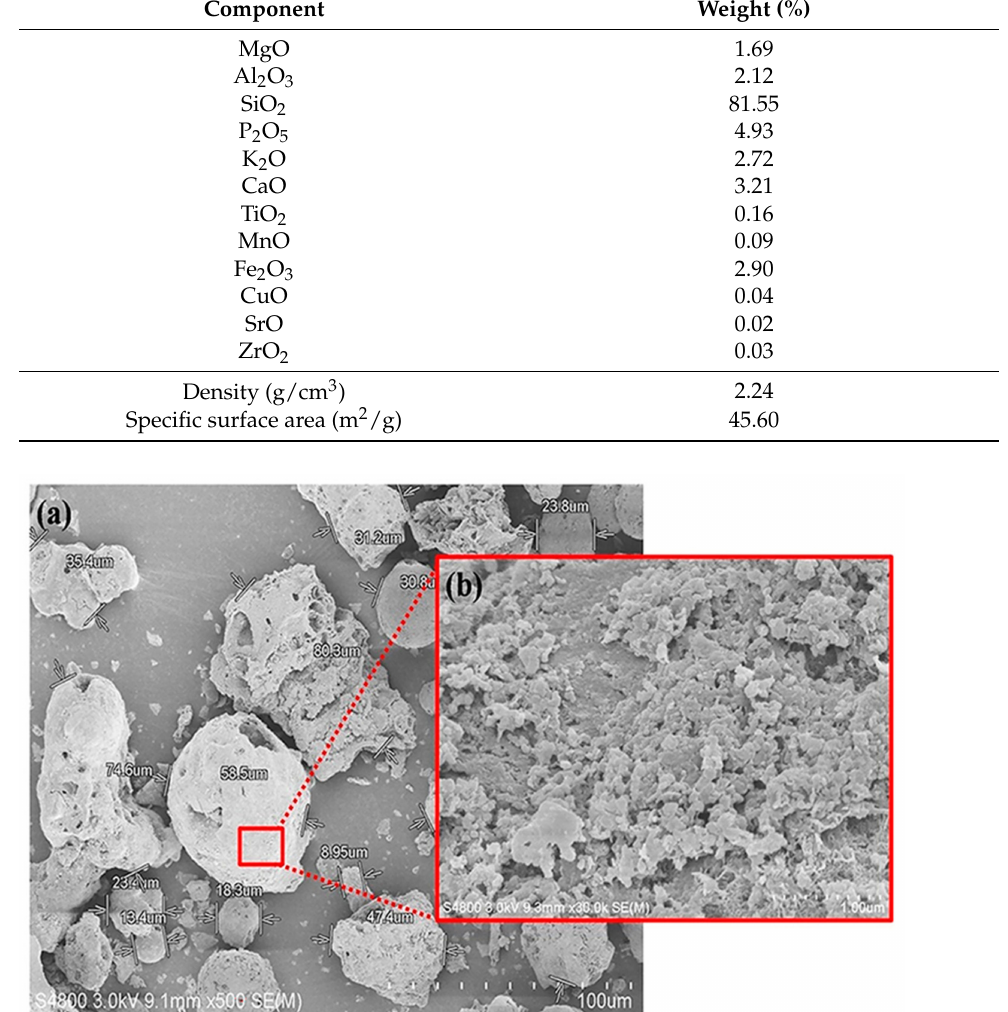
Figure 1. SEM micrograph of ( a ) OPA particles at 500 × magnification and ( b ) surface of OPA at 30,000 ×